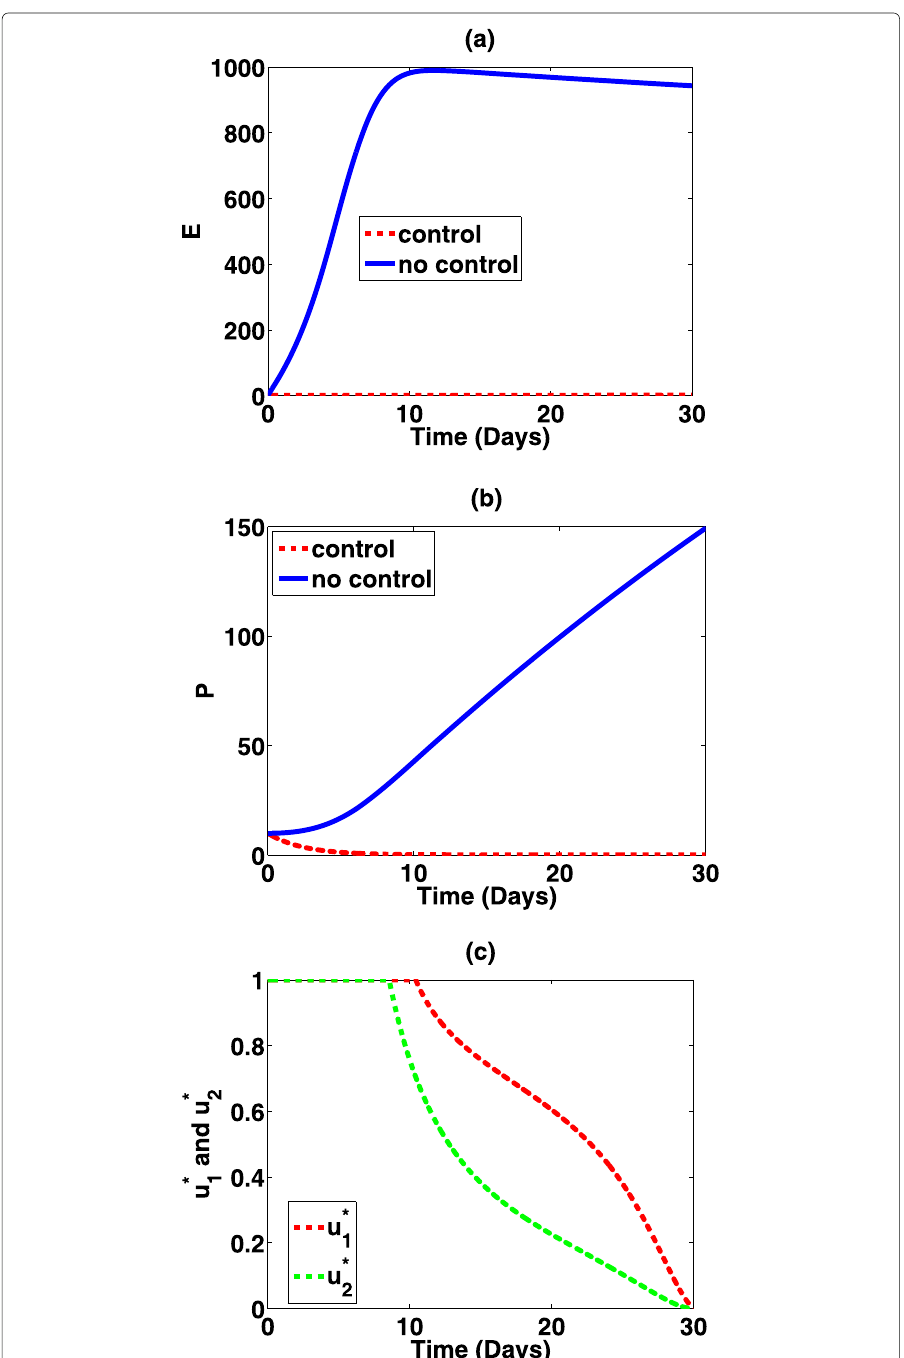
Fig. 4 a – c Optimal states and control profile for control strategy C